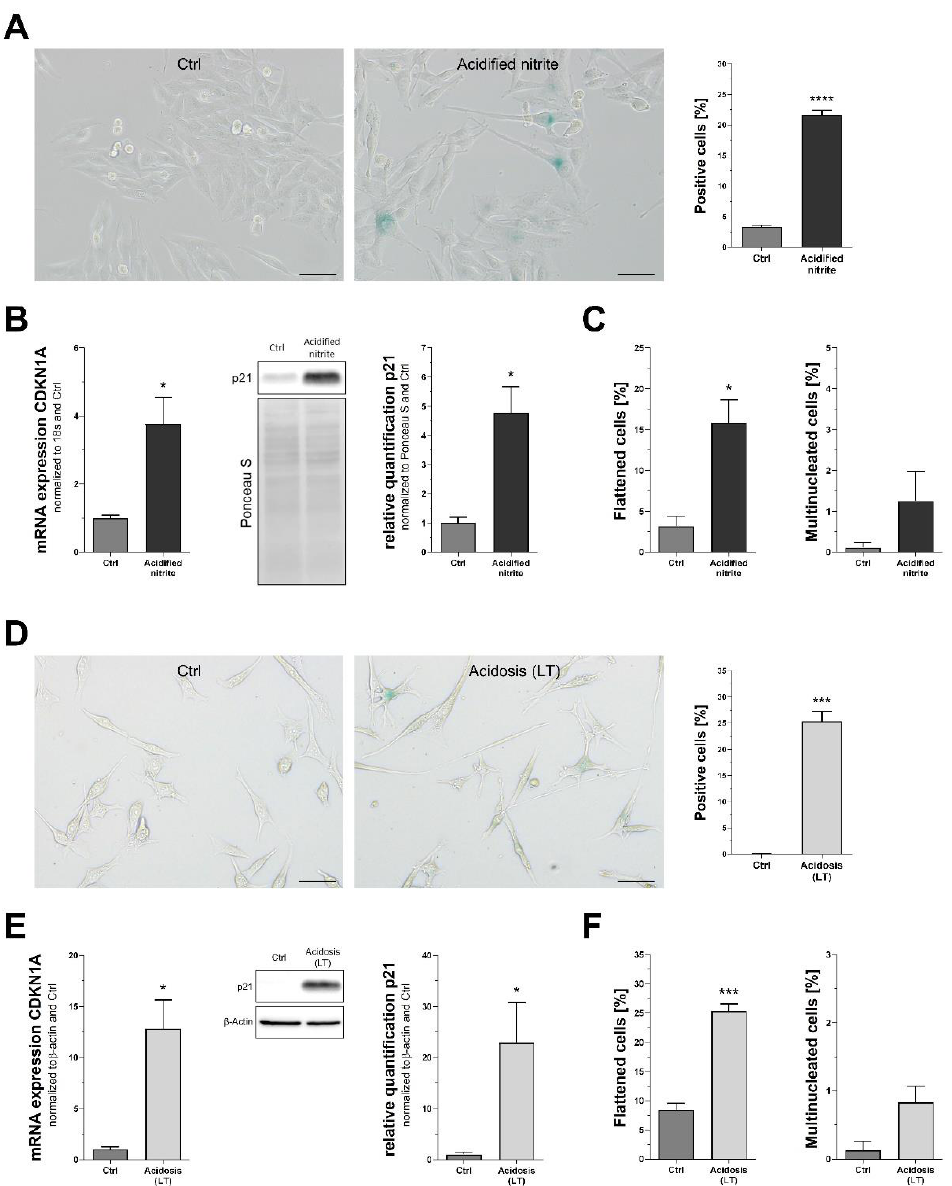
Figure 5. Validation of selected markers in malignant melanoma cells. ( A – C ) Mel Juso cells treated with acidified nitrite showed increased SA- β -Gal staining ( A ), p21 mRNA and protein ( B ), and some effects on morphology ( C ). ( D – F ) Mel Im cells during long term (LT) acidosis were found to have strong SA- β -Gal activity too ( D ), accompanied by p21 mRNA and protein ( E ) as well as morpholog- ical alterations ( F ). Scale bars equal 50 µm. Bars are shown as mean ± SEM (Student’s t -test). (*: p < 0.05, ***: p < 0.001, ****: p < 0.0001).